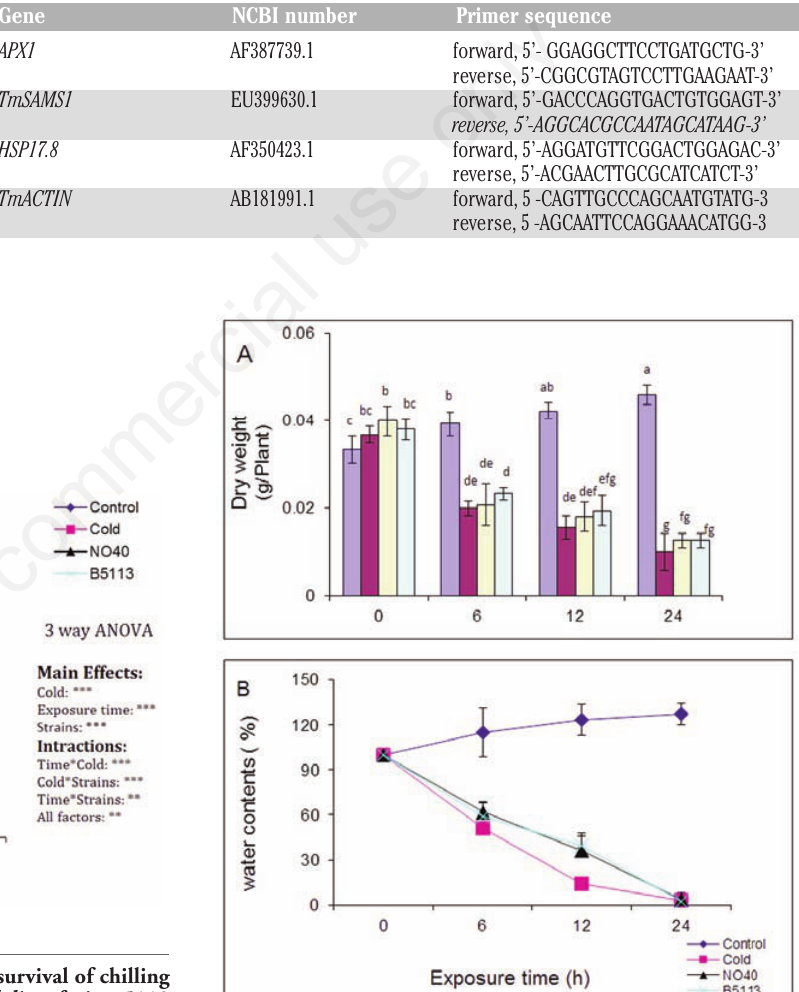
Table 1. Gene specific primers and genes from Triticum aestivum used for RT-PCR analyses